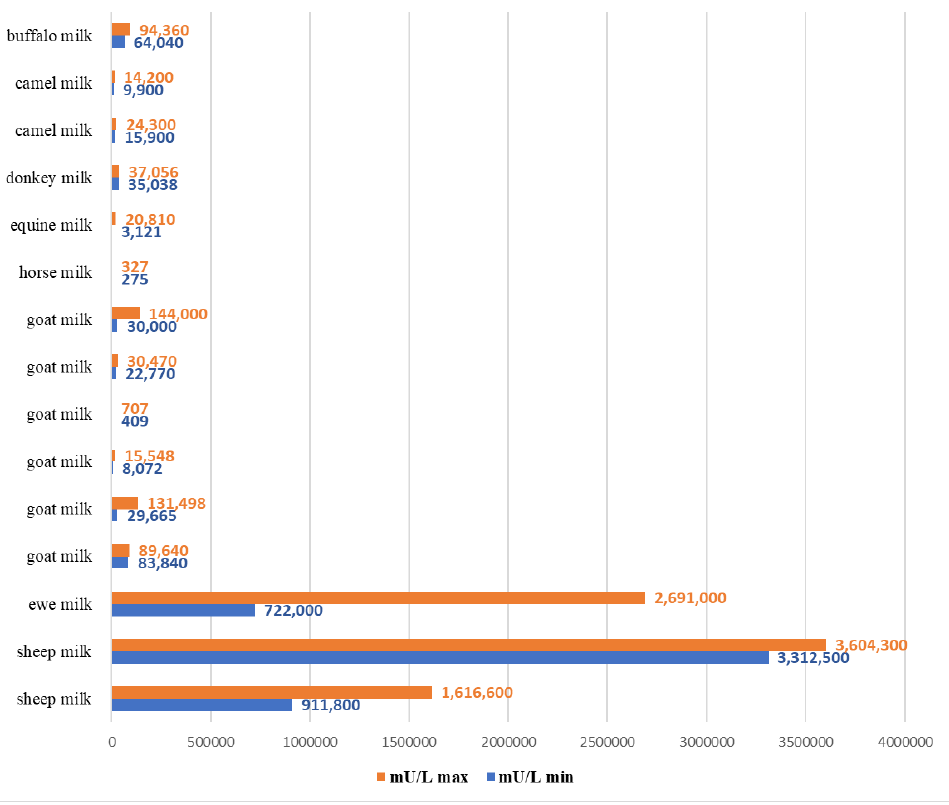
Figure 4. Means of ALP activities in non-cow pasteurized milks [22,29,33]. The available data on ALP in raw and pasteurized sheep milk vary between studies. According to Lorenzen et al. [13], the ALP average was 1413 U/L, while Jakob et al. [23]